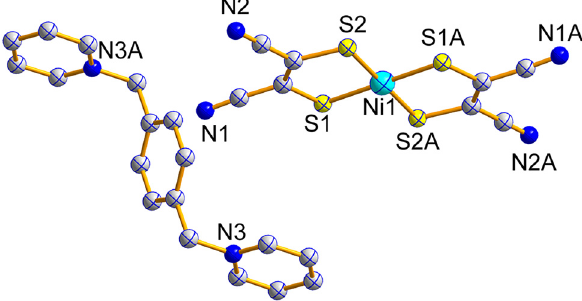
Table 1 contains crystallographic data and Table 2 contains the list of the atoms including atomic coordinates and displacement parameters.